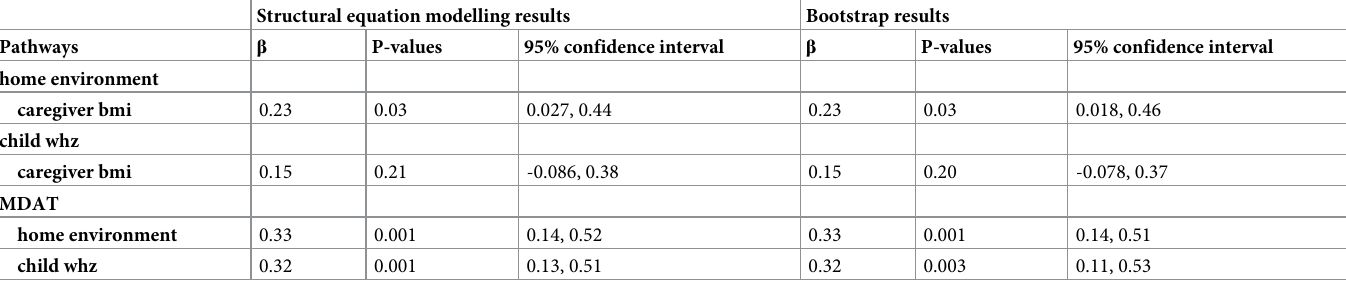
Table 2. Standardized beta-coefficients and bootstrap results for direct pathways between caregiver BMI, the home environment, child nutritional status according to WHZ, and development in children with SAM. Structural equation modelling